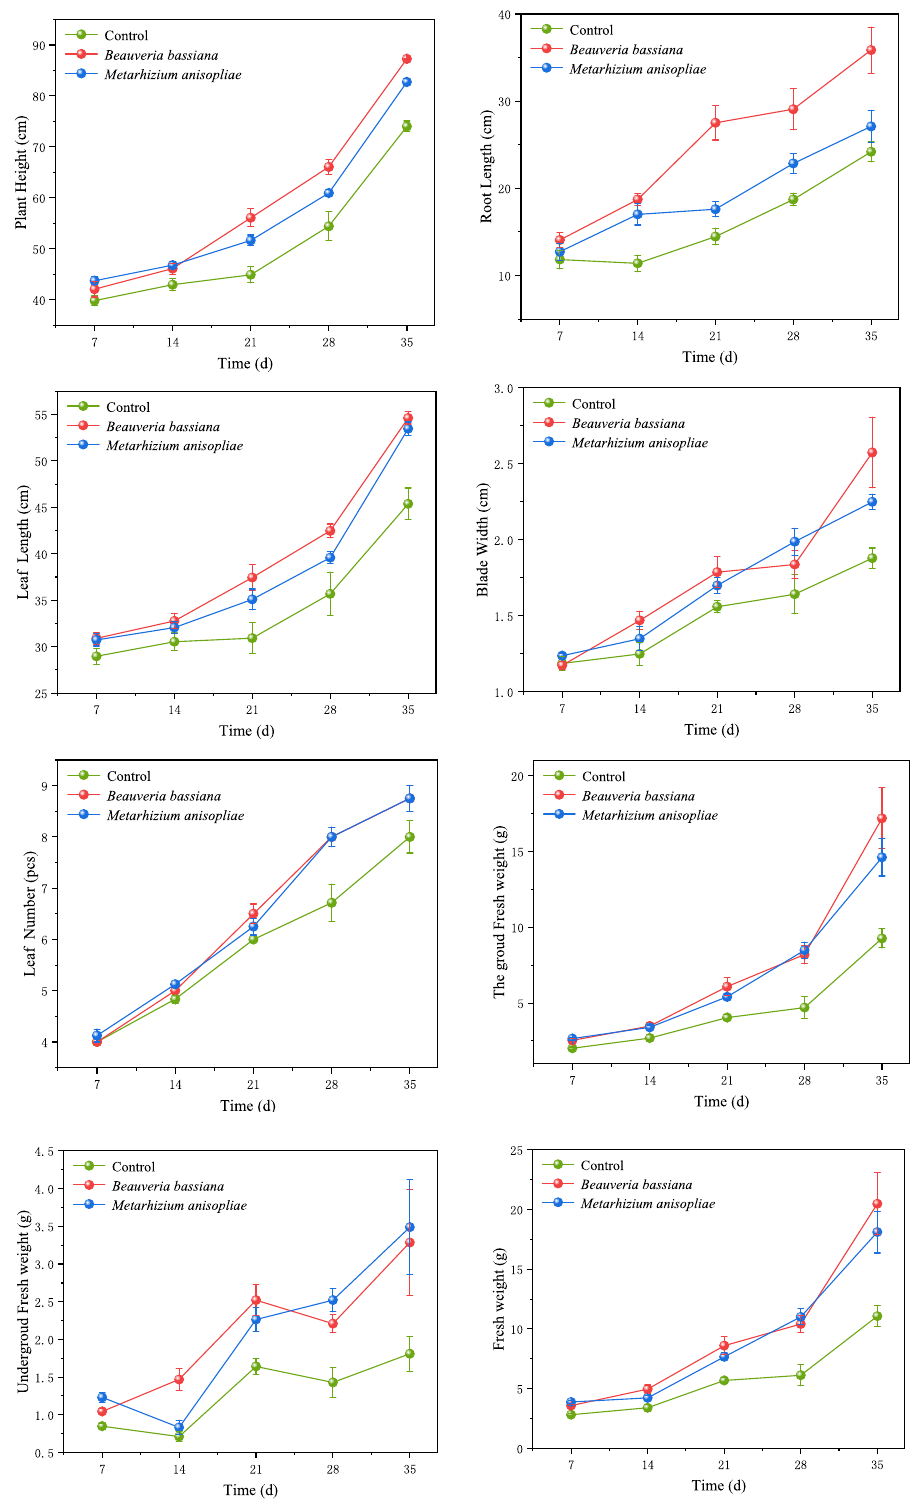
Figure 2. Temporal effects of B. bassiana and M. anisopliae on growth indexes of